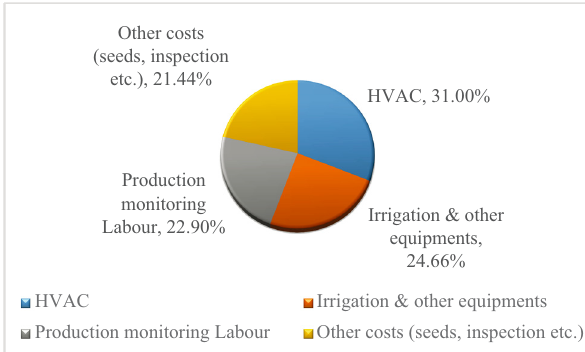
Figure 14: Greenhouse energy analysis pie chart showing the relative costs of